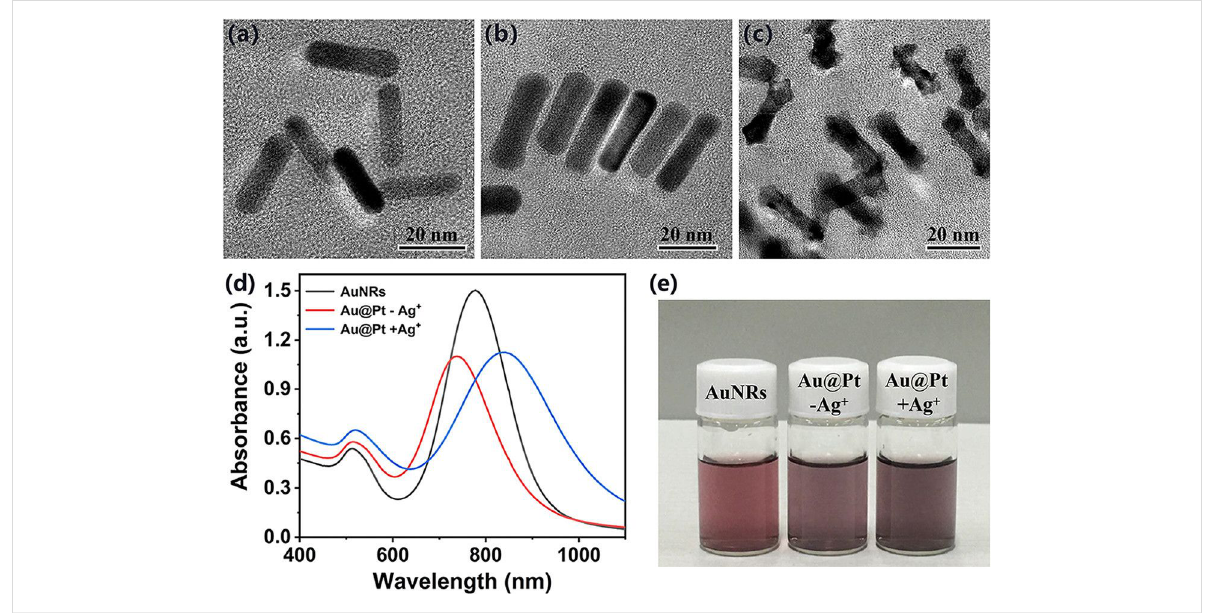
Figure 1: TEM images of (a) AuNRs, (b) Au@Pt − Ag + , and (c) Au@Pt+Ag + . (d) Absorption spectra of AuNRs (black), Au@Pt − Ag + (red), and Au@Pt+Ag + (blue). (e) Dispersibility of AuNRs, Au@Pt − Ag + , and Au@Pt+Ag + in water. Annotation: Au@Pt − Ag + and Au@Pt+Ag + represent Au@Pt